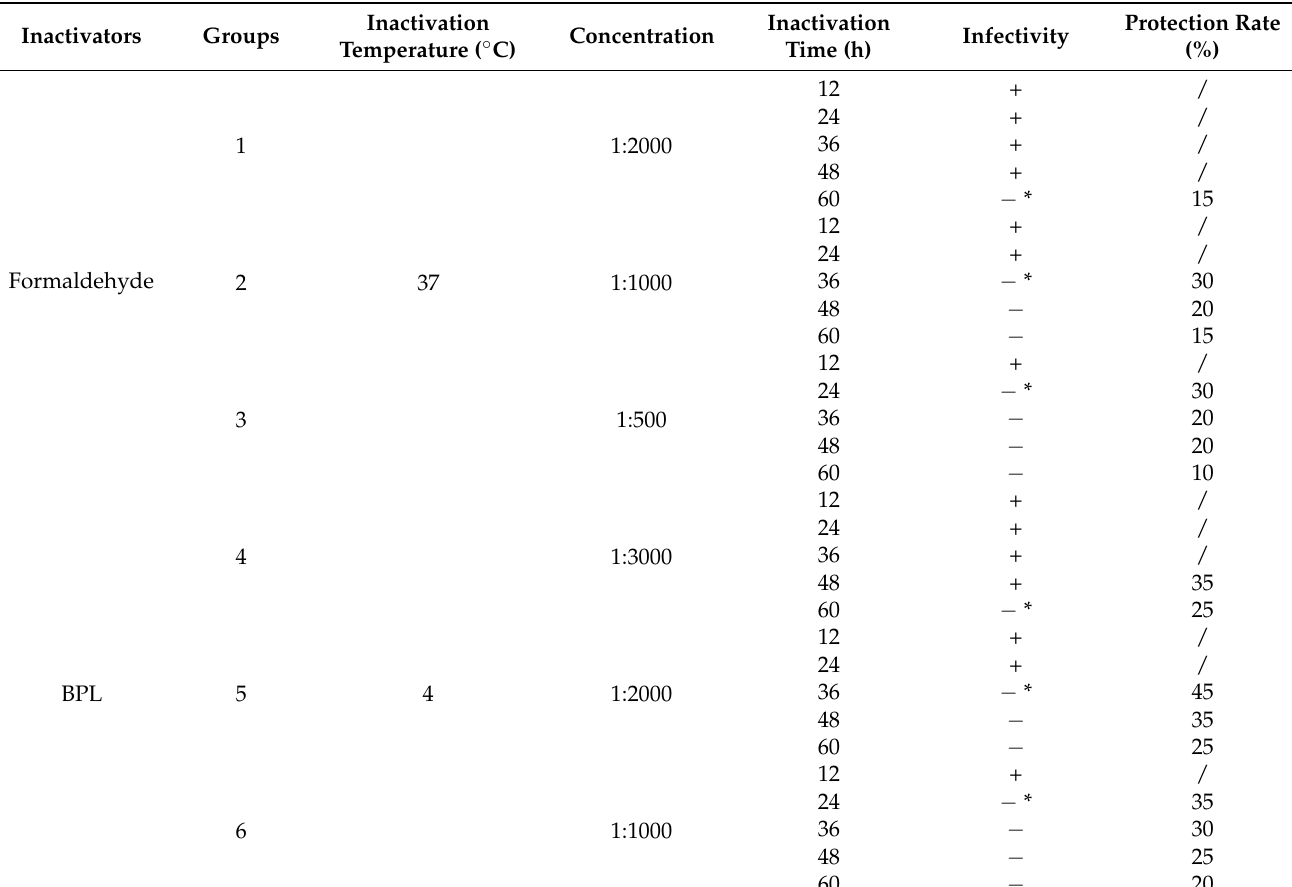
Table 1. Infectivity and immunogenicity of tilapia lake virus (TiLV) inactivated with formaldehyde at 37 ◦ C and β - propiolactone (BPL) at 4 ◦ C. Inactivators Groups